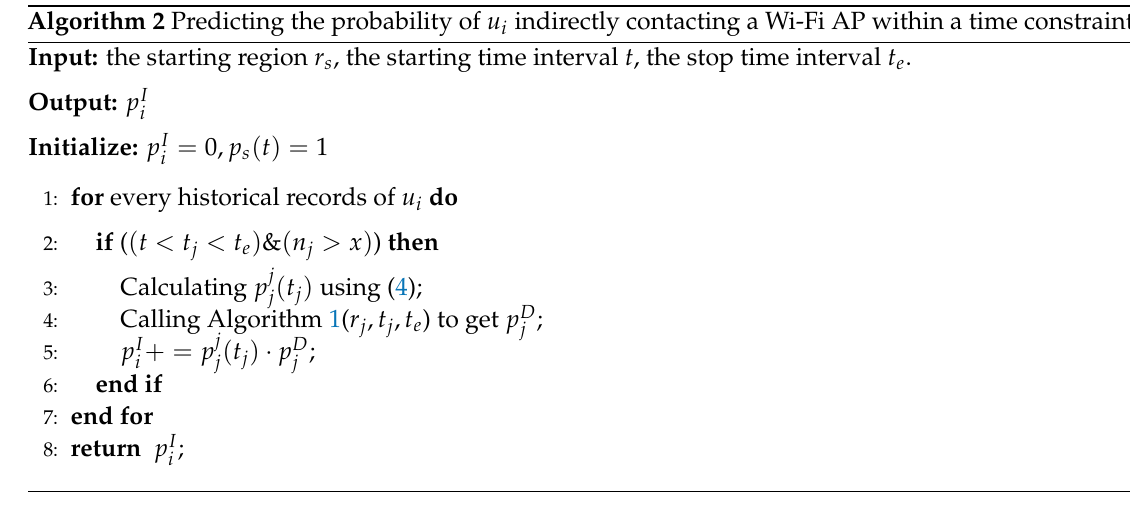
Algorithm 2 Predicting the probability of u i indirectly contacting a Wi-Fi AP within a time